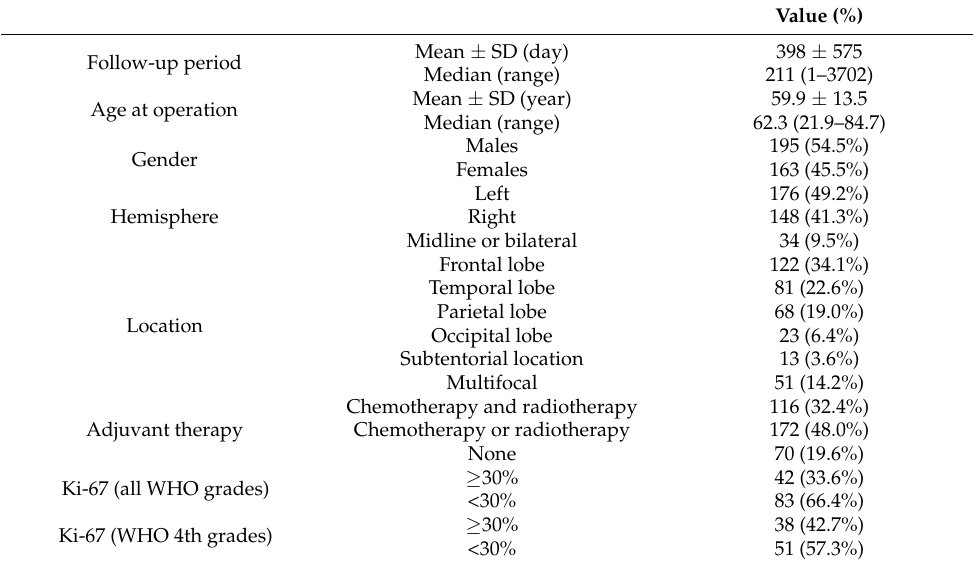
Table 1. The clinical characteristics of patients with glial tumours ( n =